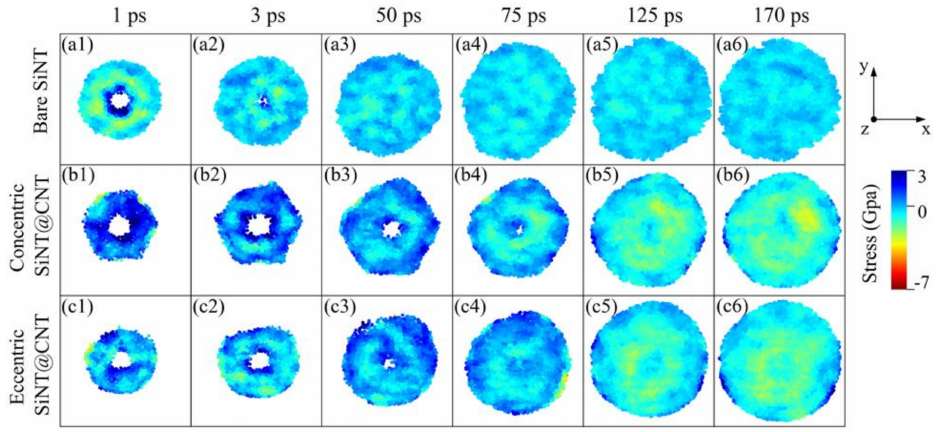
Figure 6. Stress-distribution maps of ( a1 – a6 ) bare SiNT, ( b1 – b6 ) concentric SiNT@CNT, and ( c1 – c6 ) eccentric SiNT@CNT during lithiation, positive (+) and negative ( − ) values correspond to tensile and compressive stresses,